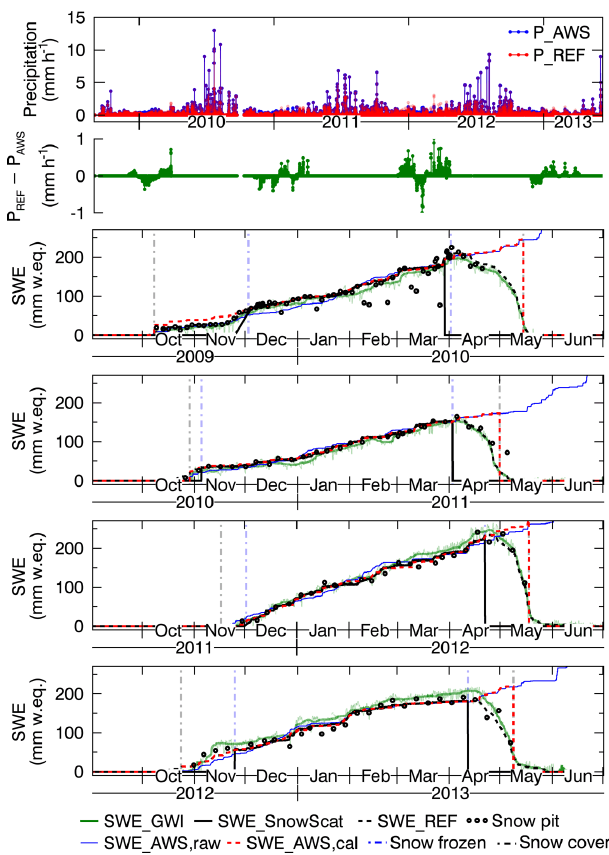
Figure A1. Top: precipitation from the AWS, adjusted precipita- tion (P REF ), and difference between both. Below: SWE time series derived from different methods are shown: snow pit data (black bul- lets), GWI (green), and SnowScat (black). Blue and red lines are the cumulated precipitation of the AWS and the adjusted precipitation P REF . Vertical dashed–dotted lines indicate snow freeze and melt (light blue) and the period of snow-covered ground (gray).